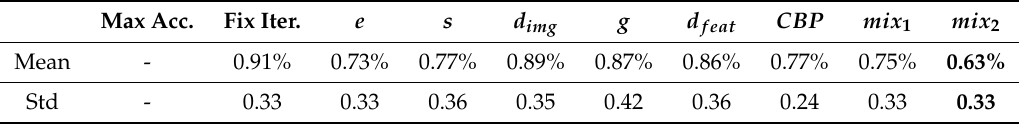
Table 4. Mean and standard deviation of the difference between the accuracy obtained with the use of a validation set and the proposed measures on STL test set. Max